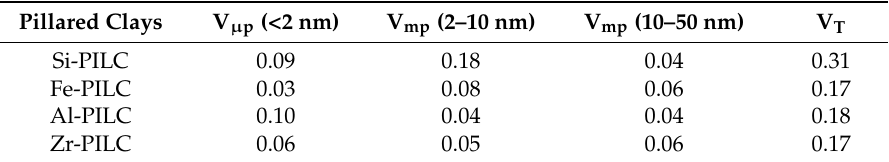
Table 3. Cumulative volumes for the pillared clays.